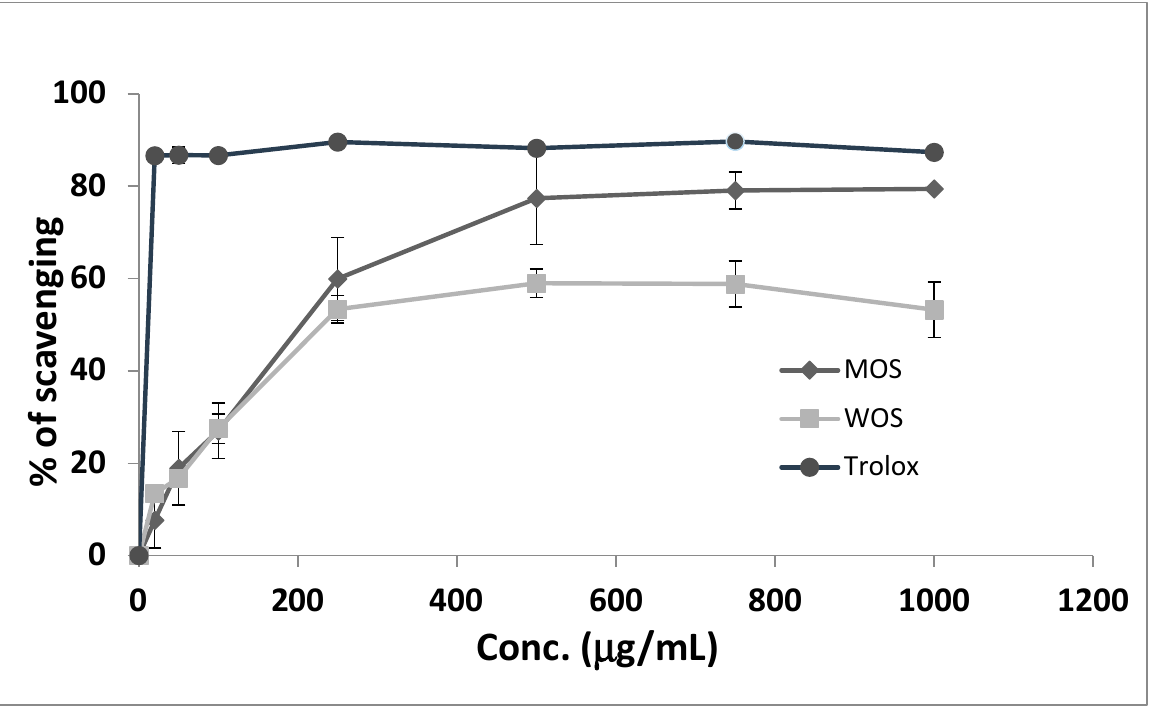
Figure 3. Determination of DPPH radical scavenging activity of MOS and WOS. Trolox was used as a positive control. All experiments were performed in triplicates. Data are expressed as mean ± SEM. Table 1. Phytochemicals of O. stamineus from methanol extract verified by GC/MS. Peak